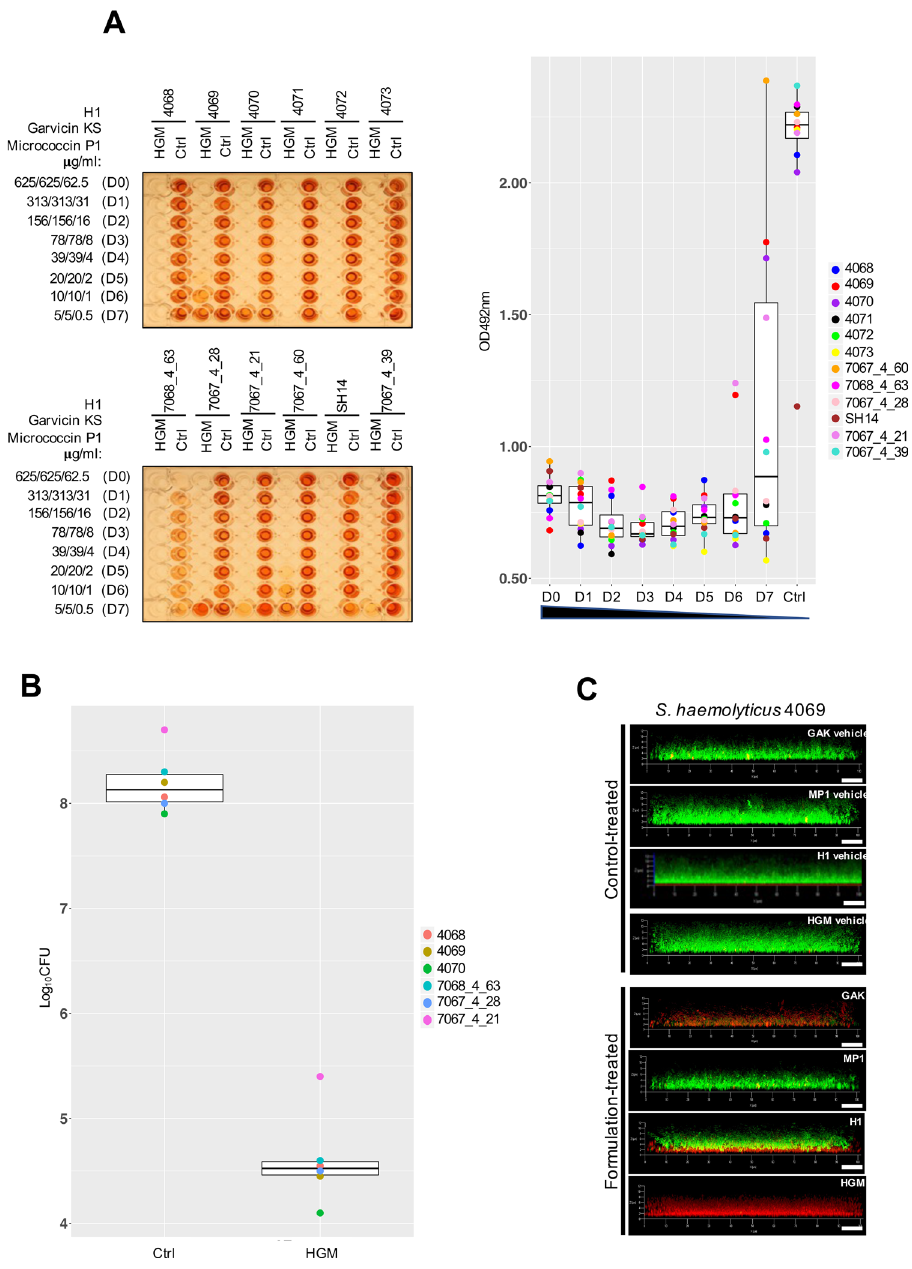
Figure 4. The tricomponent antimicrobial combination effectively inhibits the metabolic activity and viability of S. haemolyticus biofilm-associated cells in vitro. ( A ) The left panels show representative images of BOAT assays performed upon 24 h treatment with the tricomponent combination (HGM: H1, GarKS, MP1) for the indicated strains. The concentration (μg/ ml) of the individual antimicrobials in the dilutions (dilution factors: D0 to D7) is indicated on the far left of the images. As controls, the assay was performed using the vehicles at their final concentrations (Ctrl). The development of red color indicates the retention of metabolic activity, and its quantification was performed by spectrophotometry at OD 492 . Metabolic activity values were plotted as a function of the dilution factor for the antimicrobial combination (right panel). Shown is the median distribution (thick line within boxes) and the degree of variability (amplitude of the box or inter quartile region (IQR)) of the metabolic activities for the indicated strains measured at increasing dilution factors (D0–D7). The boxplot components (whiskers and outliers) are displayed as specified in Fig. 3. Note that the treatment maintained the metabolic activitiy under detectable levels up to D6 for most strains. ( B ) The logarithmic colony formation unit (Log 10 CFU) was calculated after the BOAT assays were performed for the indicated strains. BOAT assays were performed as in ( A ), and the boxplot shows the median distribution of the Log 10 CFU values. The antimicrobial concentrations in the tricomponent combination were 625 μg/ ml for H1 and garvicin KS and 62.5 μg/ml for micrococcin P1. The control was performed by using the antimicrobials vehicles at their final concentration. ( C ) The S. haemolyticus strain 4069 was allowed to form biofilms on glass-bottomed chambers for 24 h, prior to treatment with the indicated antimicrobials (lower set of panels) or the respective control-vehicles (upper set of panels) as detailed in ( B ). The biofilms were subsequently stained using the LIVE/DEAD biofilm staining kit and confocal microscope images were taken using a 63 × oil immersion objective. Scale bars correspond to 10